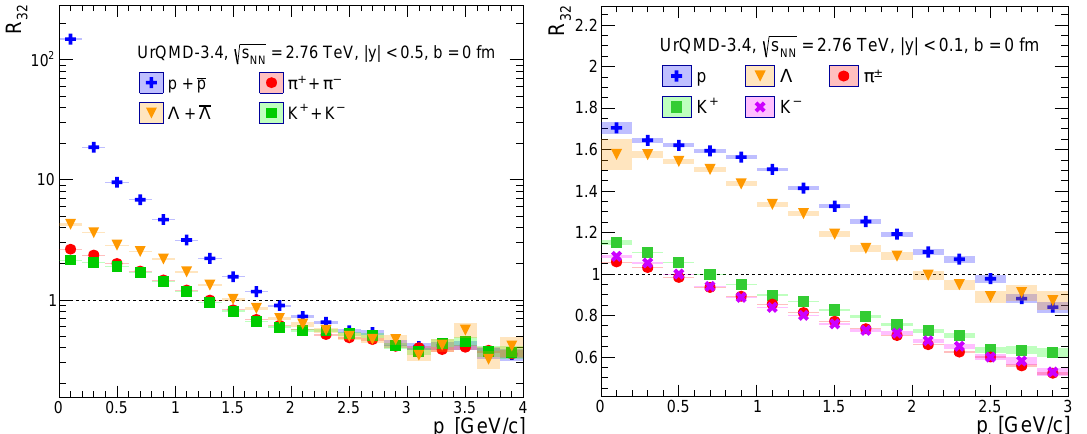
Figure 5. Ratio of transversal momentum spectra of TNC to the one of A+A collisions (3-to-2 nuclei modification factor) of hadrons obtained for the same collision energy of particle transverse momentum with the ones obtained by the UrQMD simulations. ( Left panel: ) Results for the p+C+p TNC are found at | y | < 0.5. ( Right panel: ) Results for the Pb+Pb+Pb TNC are found at | y | <